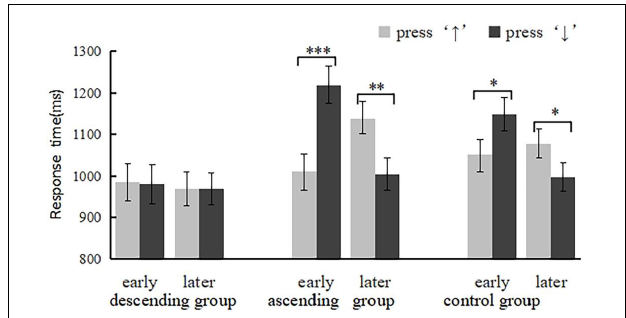
FIGURE 1 | Results from Experiment 1: mean response time as a function of priming condition (ascending group, descending group and the control group) and time type (early and later) in pressing “ ↑ ”(gray bars) or “ ↓ ”(black bars) conditions. The Error bars represent the standard errors for each condition. * p < 0.05; ** p < 0.01; *** p <